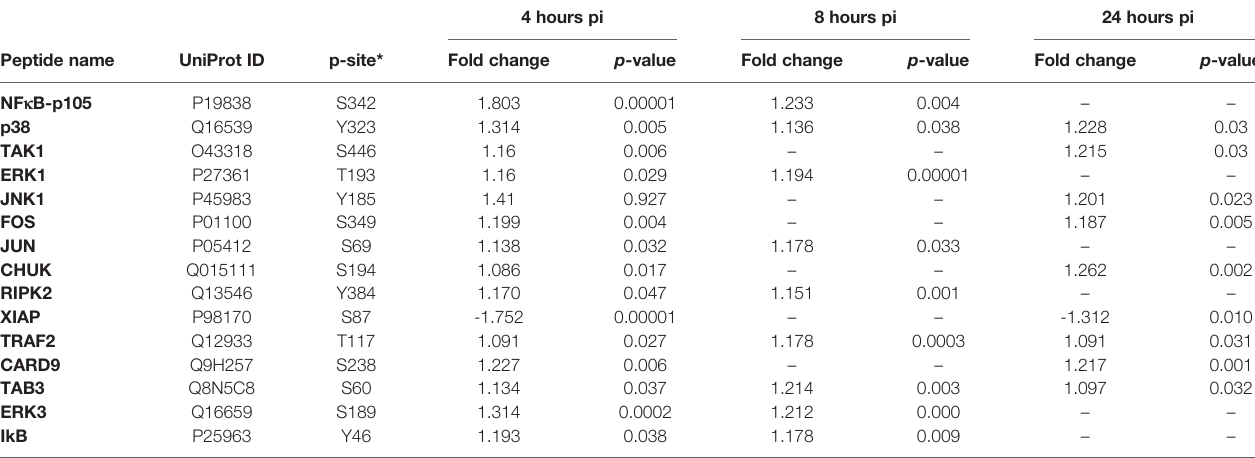
TABLE 5 | Members of the NOD-like receptor signaling pathway showing differential phosphorylation between Salmonella enterica serovar Enteritidis-infected cecal tissue and non-infected cecal